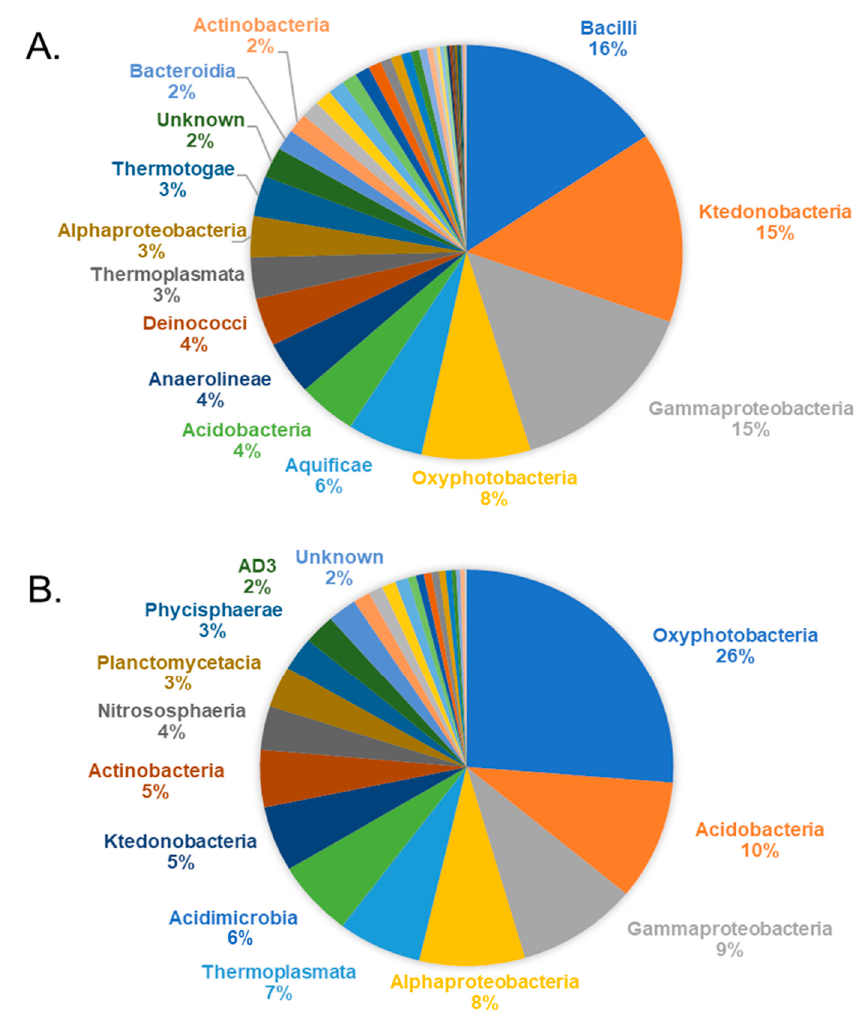
Figure 3. Overall bacterial community composition of the hot spring and soil microbiome. The actual abundances at the class level are plotted for the hot spring ( A ) and soil group ( B ). Taxa showing less than 2% relative abundance are not displayed.